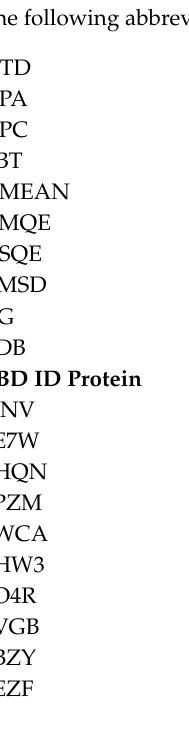
Table S1: Metabolites from Aspidosperma spruceanum , Figures S1–S6: DHFR-TS (PDB ID 3INV) and TS (PDB